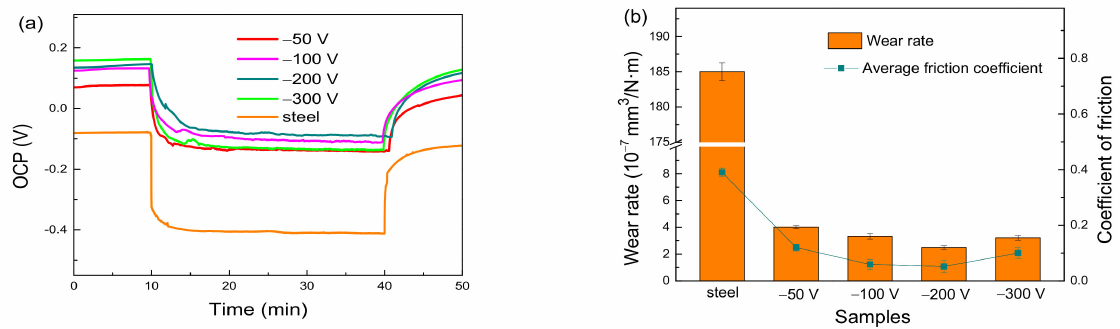
Figure 9. Evolution of OCP values before, during, and after tribocorrosion tests ( a ), and wear rate and friction coefficient during sliding ( b ) for substrate and coatings.